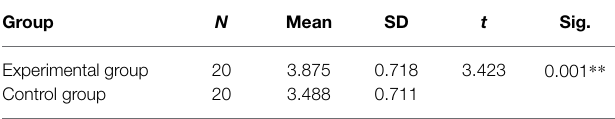
TABLE 3 | Analysis of the learning motivation of two groups. Group N Mean SD t Sig.